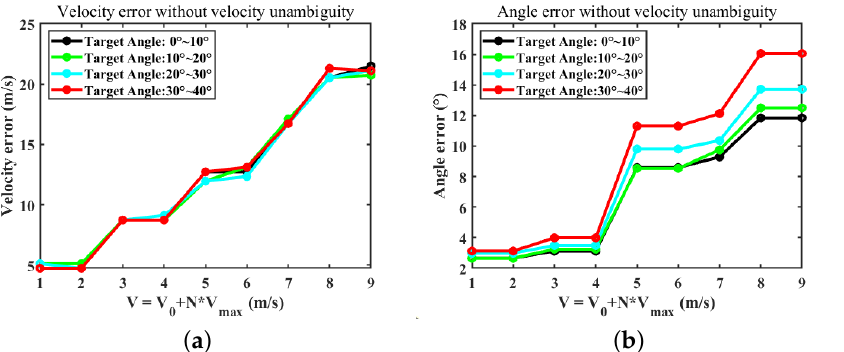
Figure 13. Velocity and angle estimation errors caused by velocity ambiguity. ( a ) Velocity estimation error. ( b ) Angle estimation